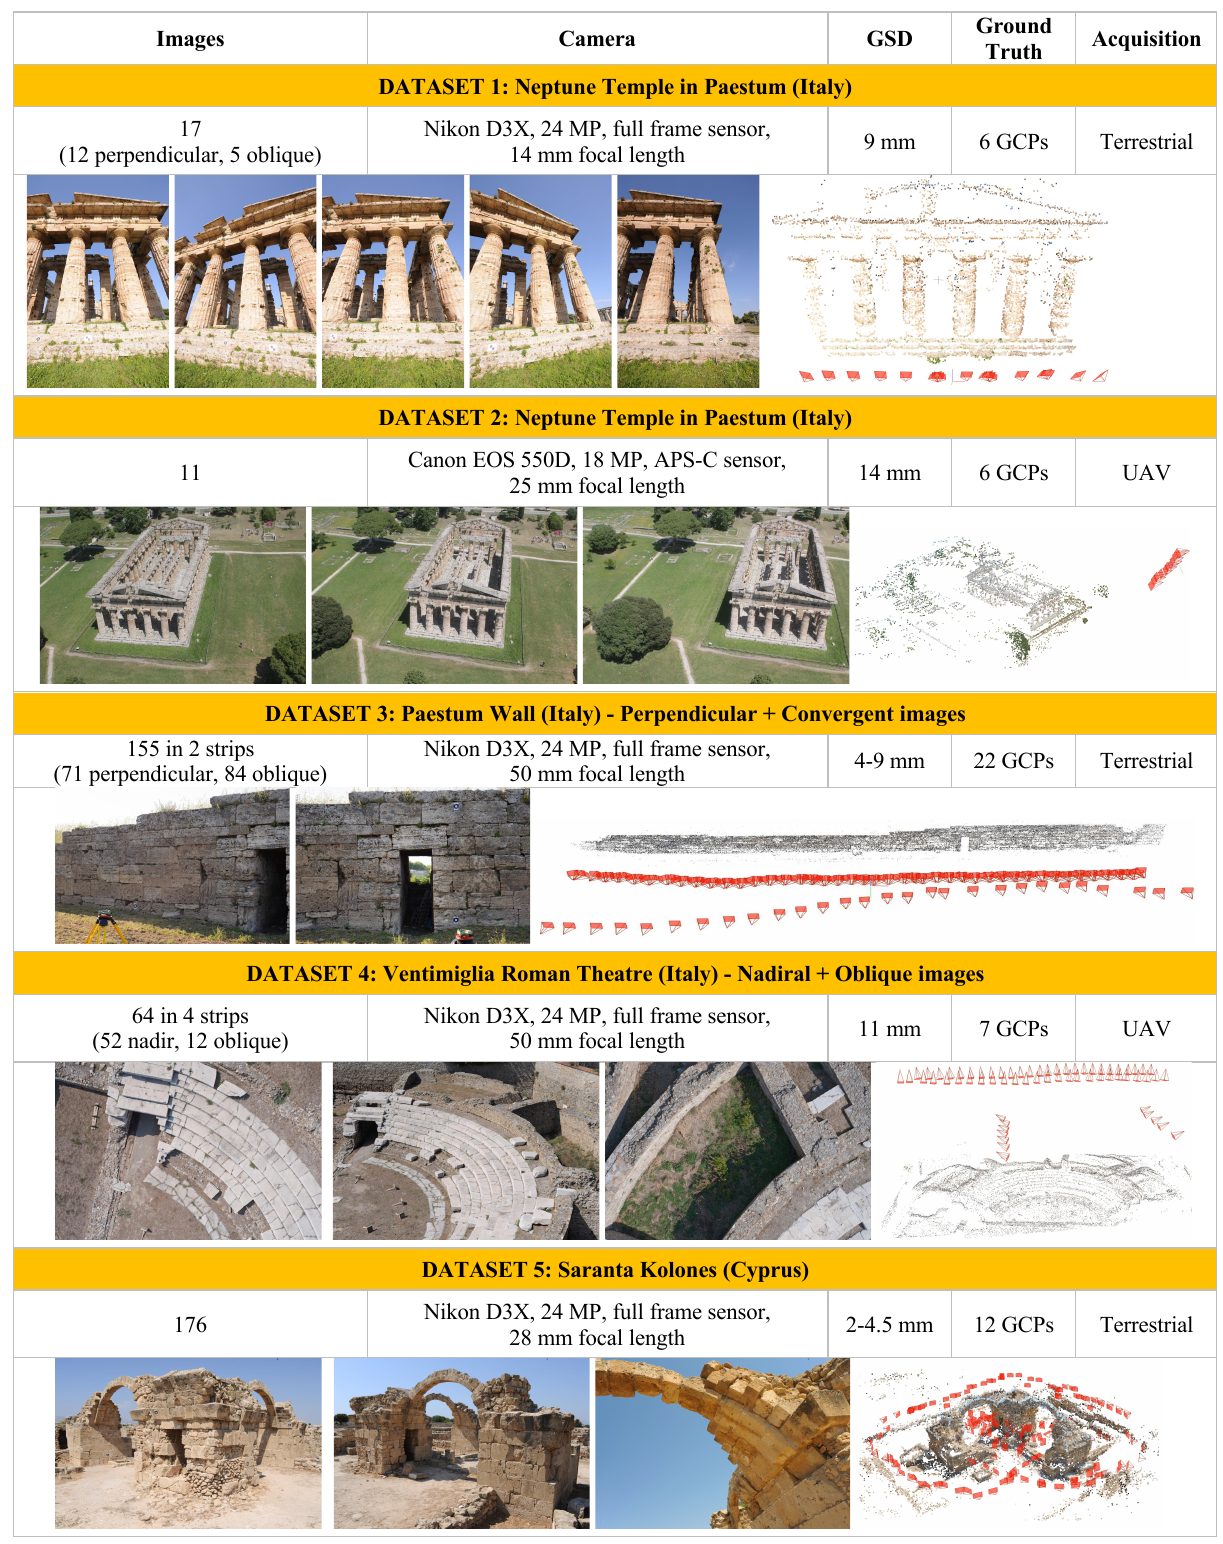
Table 1: Summary of the datasets (images and camera networks with sparse point clouds) employed in the presented evaluation. The ground truth is given by reference 3D points measured with topographic methods (GCP-like): these 3D points are not included in the bundle adjustment as constraint but used to estimate an Helmert transformation and derive RMSEs of 3D coordinates. The reported min/max Ground Sampling Distance - GSD values are resampled from the original ones considering the used image resolution (i.e., 1500x1000 px – see Section 3.6) during the